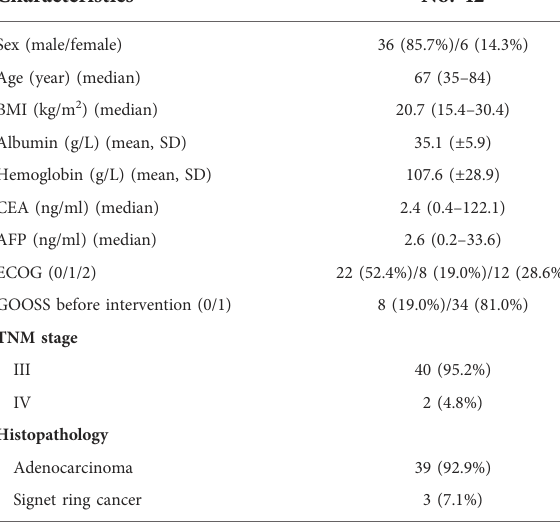
TABLE 1 Characteristics of